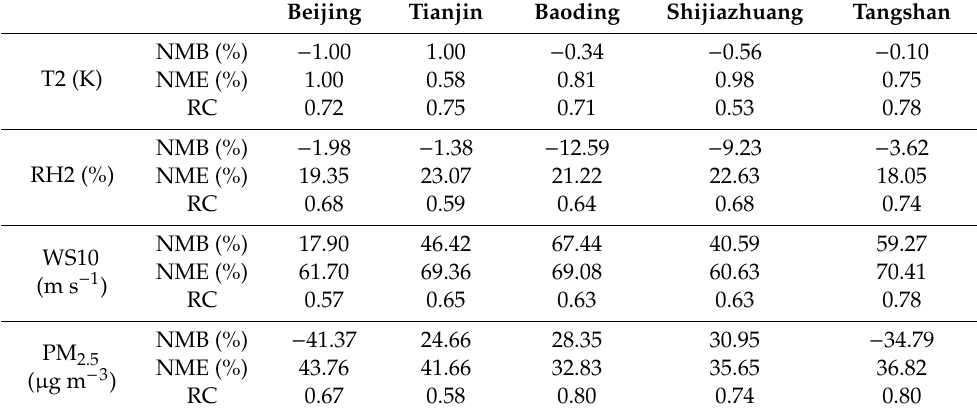
Table 3. Statistical results of the simulated and monitored